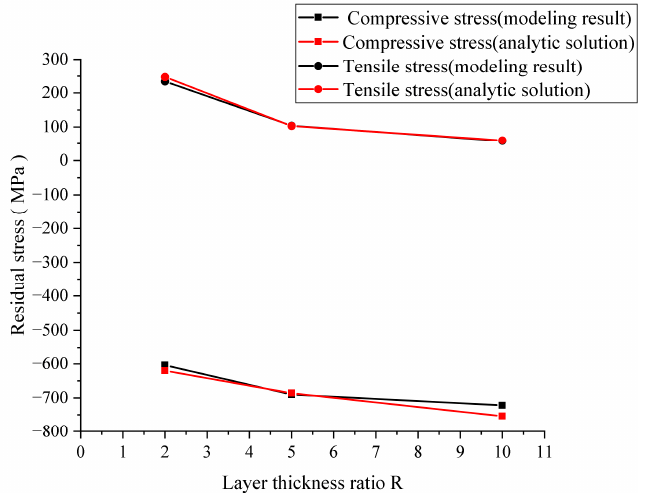
Figure 4. Theoretical values and numerical simulation results of residual stress in layered ceramics.